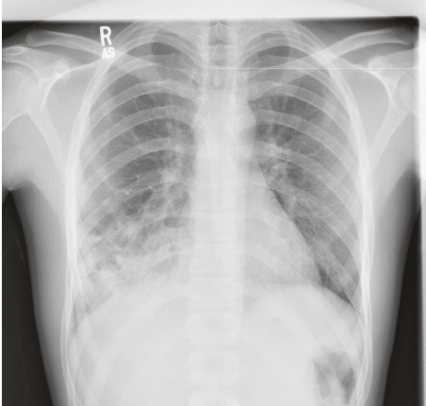
Figure 1: Chest X-ray obtained 2 hours after the trauma showing multiple cystic lesions containing air-fluid levels.